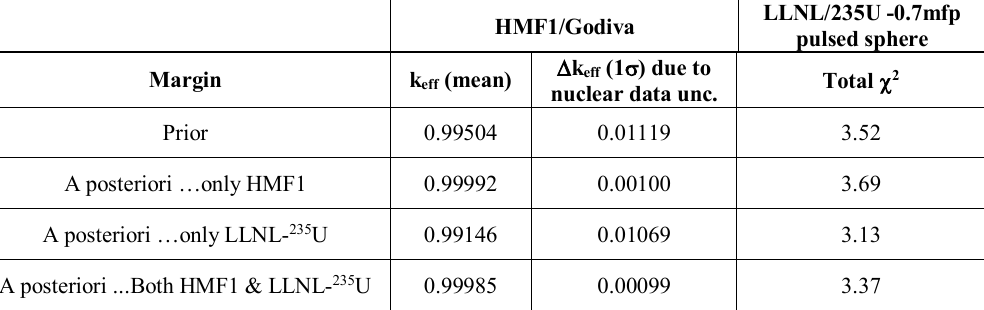
Table 2. Results of BMC adjustment for Godiva and LLNL/235U pulsed sphere Benchmarks. Calculations are performed with MCNP-6.1. The k eff statistical uncertainty <